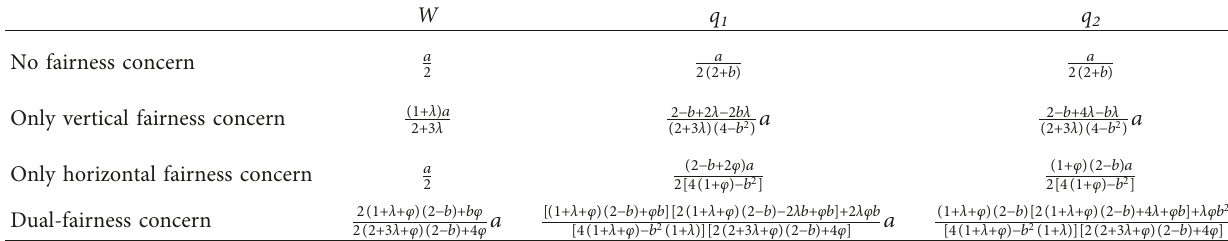
Table 3: Model findings.